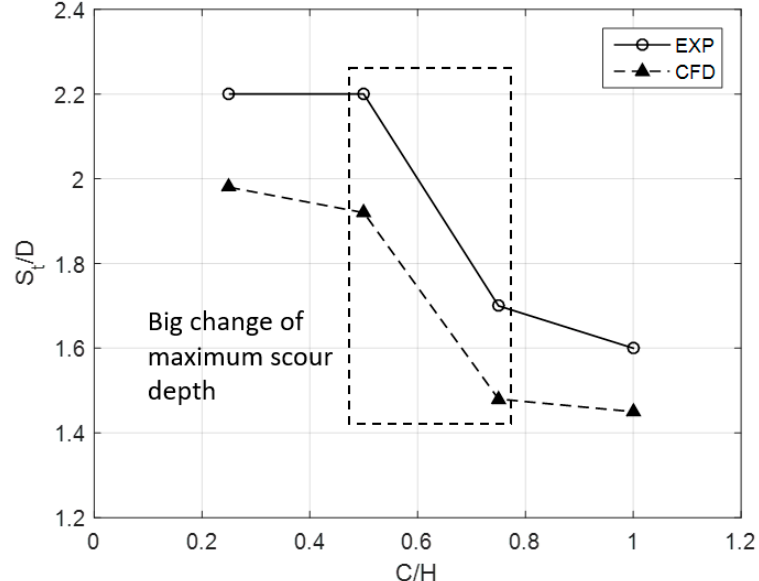
Figure 12. A comparison of equilibrium scour depth between the experiment and numerical simulations at different tip clearances.